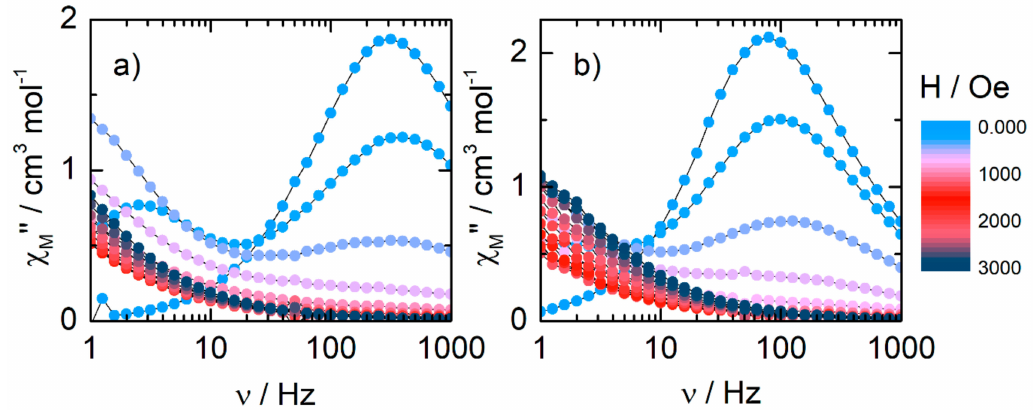
Figure 7. Frequency dependence of χ M ” at 2 K at various external fields for ( a ) 1 and ( b ) 2 .